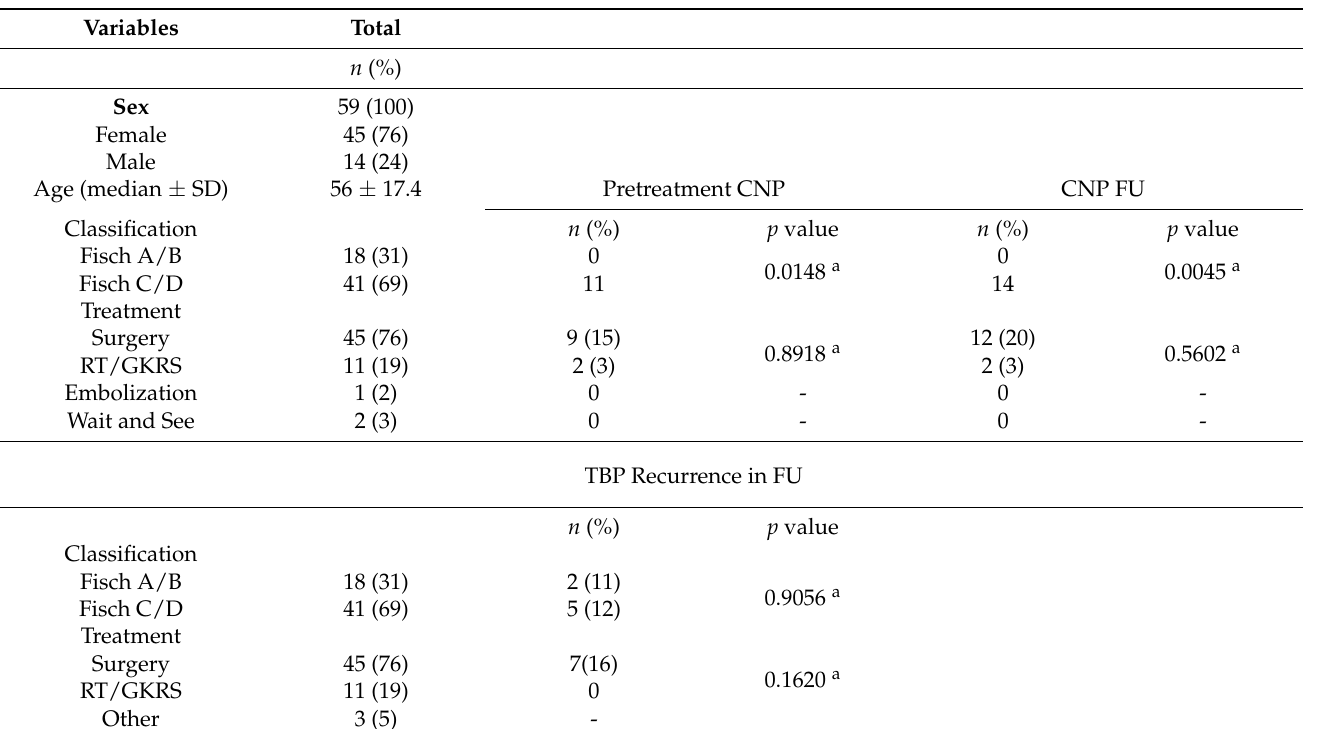
Table 2. Descriptive statistics of patient population with variables gender, age, Fisch class and treatment alternative.